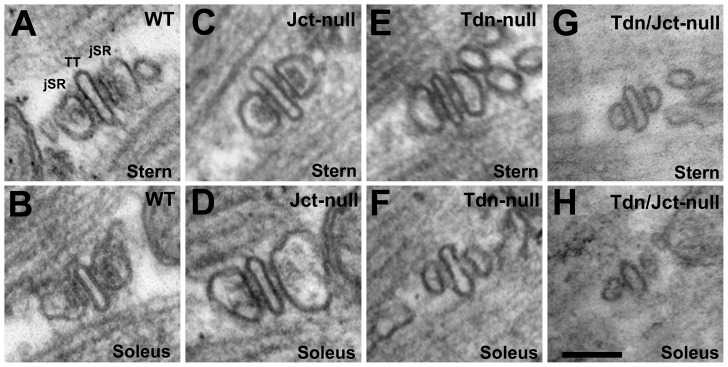
Sections at right angle to triads in sternomastoid (top row) and soleus (bottom row) muscles illustrating changes in dimensions of the jSR cisternae relative to WT.Compare with Table 1. C and D) In Jct-null muscles the triads are slightly smaller than WT in sternomastoid (A), but somewhat larger in soleus (compare B and D; E and F) in Tdn-null fibers the jSR cisternae are smaller in all muscles; G and H) in the double null the dimensions are further reduced. Bar: A–H, 0.1 µm.